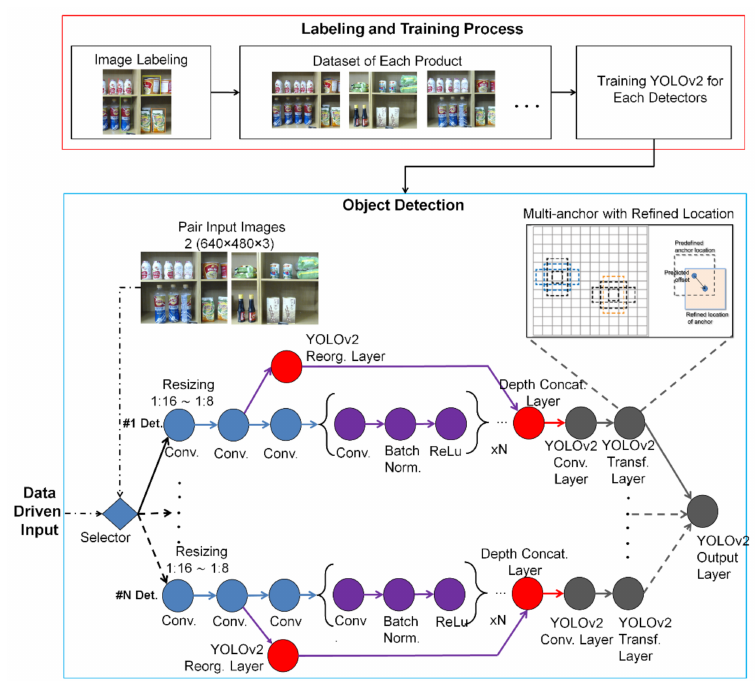
Figure 5. Data-driven mode of YOLOv2 with selective detector. The #1 Det is order of detectors which depend on kind of the products in the shop. Upper box (red) is labeling process for each detector in training stage. Lower box (blue) is parallel detector by data-driven mode in detection stage of the modified